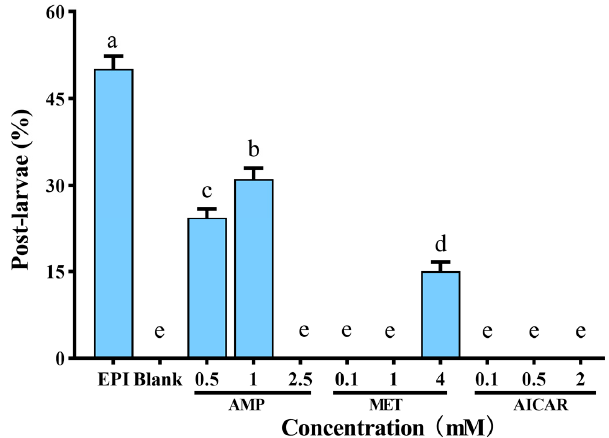
Figure 9. Larval metamorphosis of M. coruscus in response to AMPK activators at 72 h. EPI: epinephrine (10 − 4 M); Blank: autoclaved filtered seawater (AFSW); AMP: Adenosine monophosphate; MET: Metformin; and AICAR: Acadesine. The abscissa values represent the different test concentrations of the medicines.